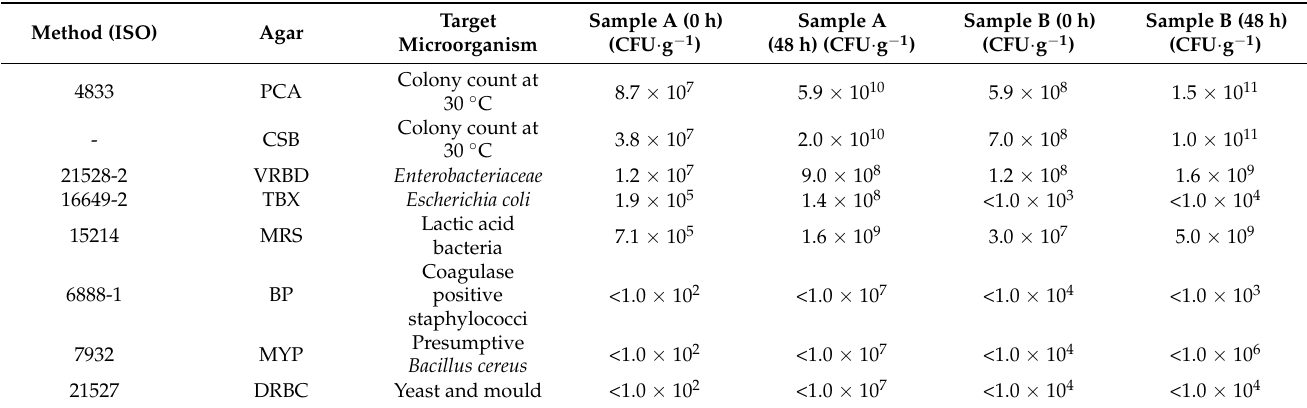
Table 3. Colony count of target